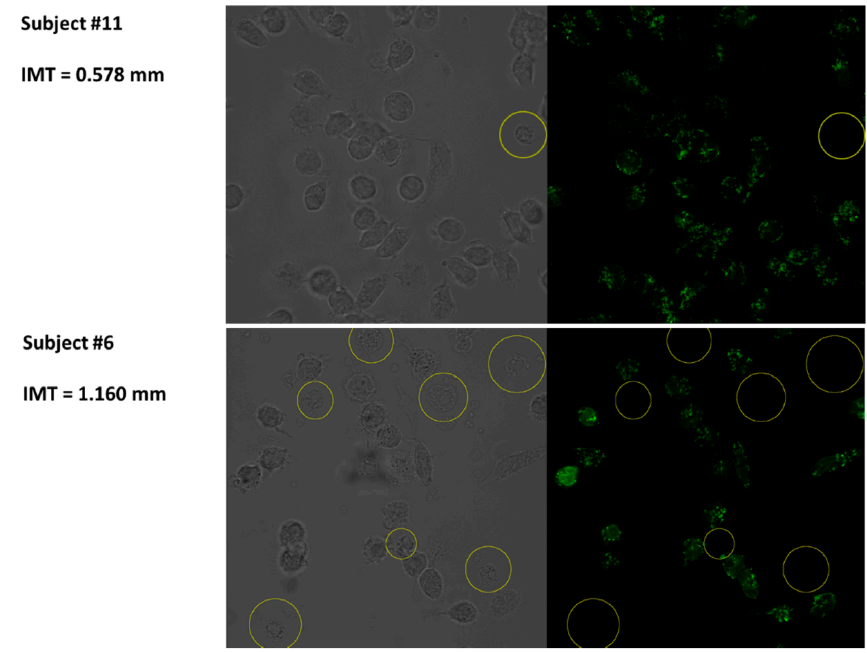
Figure 1. Identification of MitoTracker-low CD14+ human monocytes. Shown is a fluorescent micrograph of the monocyte primary culture from two subjects with different intima-media thickness (IMT) values, corresponding to a normal (Subject 11) and an atherosclerotic (Subject 6) status, stained with MitoTracker Orange CMTMRos. Monocytes were incubated with 100 nM of MitoTracker Orange CMTMRos for 20 min. In the left panel, the cell morphology can be seen, and the fluorescent signal from the corresponding cells is shown in the right panel. MitoTracker-low cells are indicated with yellow circles. Shown is a representative example of a field of